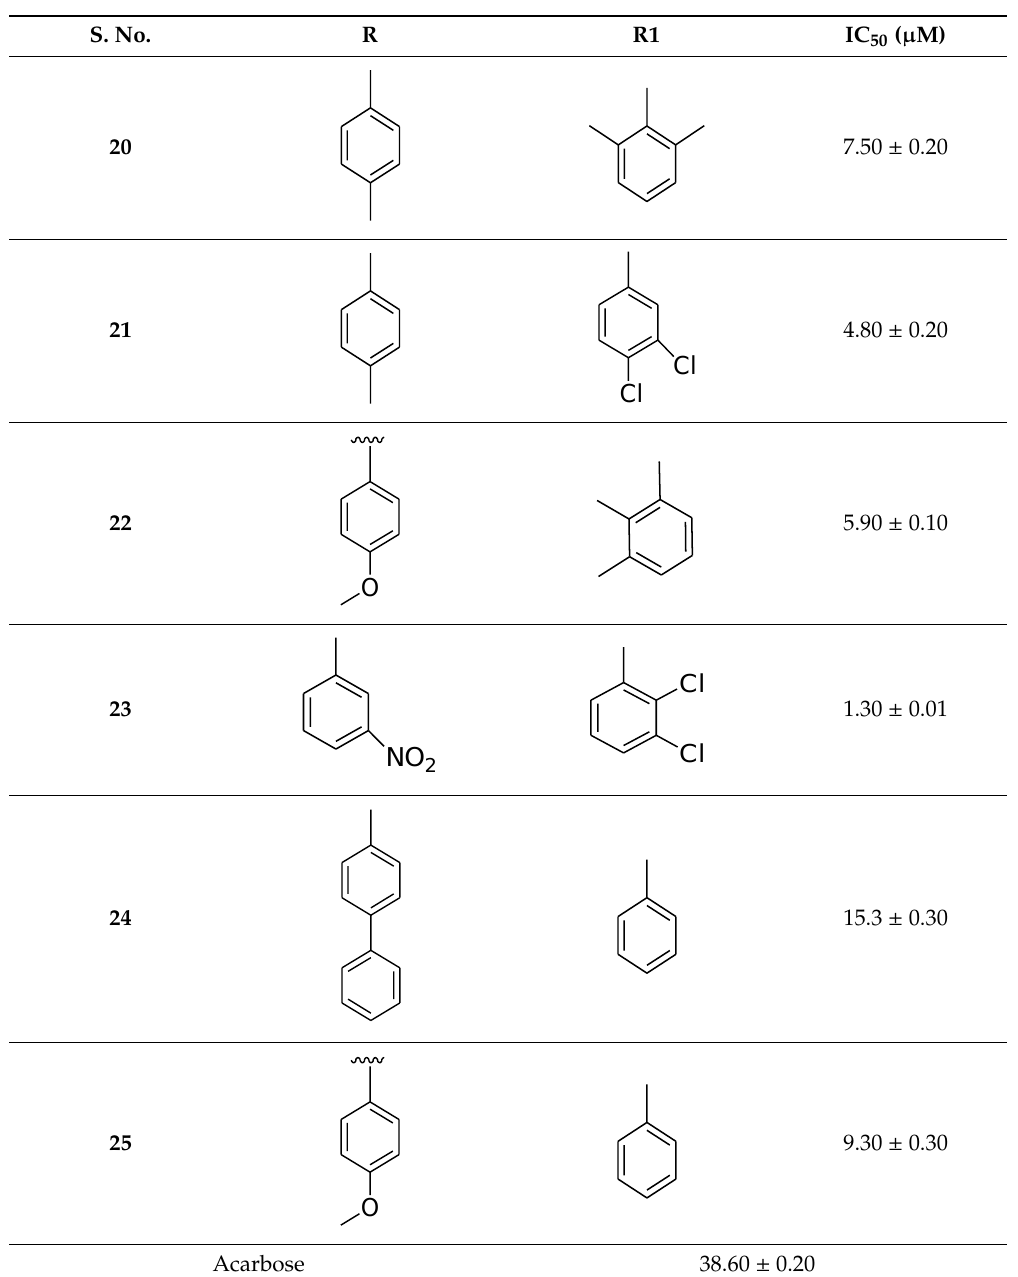
Table 1. Structure of triazinoindole-based thiosemicarbazide analogs and their α-glucosidase activity. S. No.